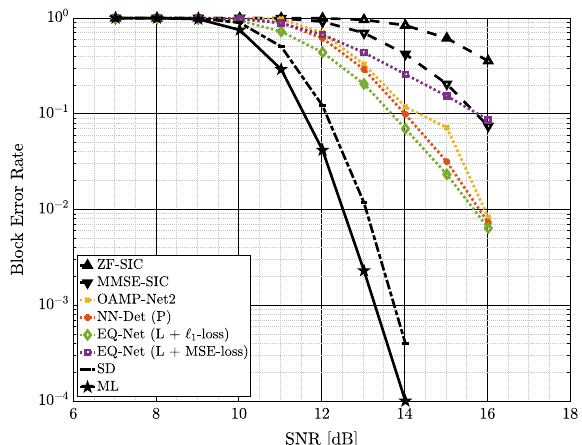
Fig. 7 Estimation (MIMO detection) performance of EQ-Net (including an ablation result on using MSE loss for the second training stage) against state-of-the-art approaches in 4 × 4 , 16-QAM, Rayleigh fading, and